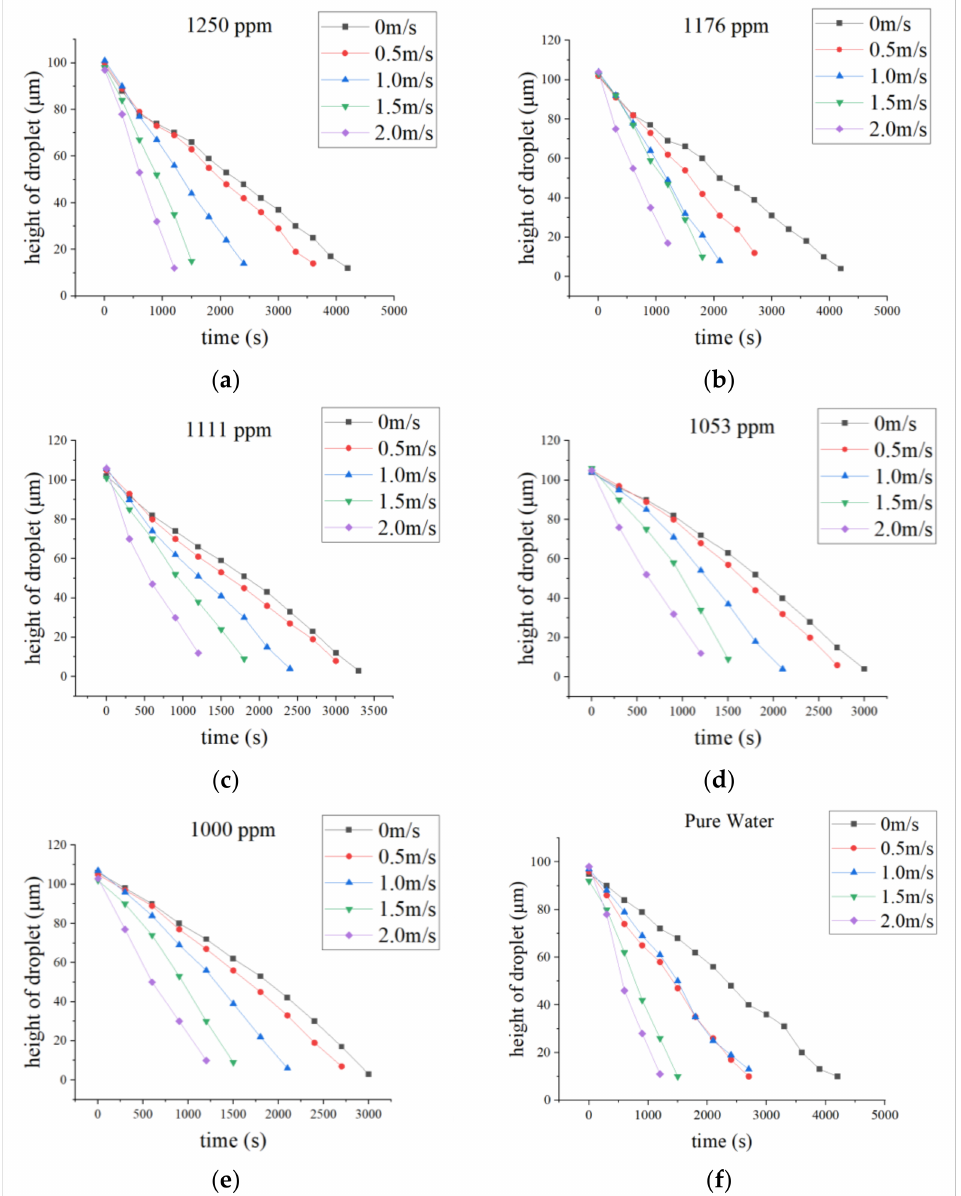
Figure 4. Variation in the height of different liquid on peach leaves at different wind speeds: ( a ) 1250 ppm, ( b ) 1176 ppm, ( c ) 1111 ppm ( d ) 1053 ppm, ( e ) 1000 ppm, and ( f ) pure